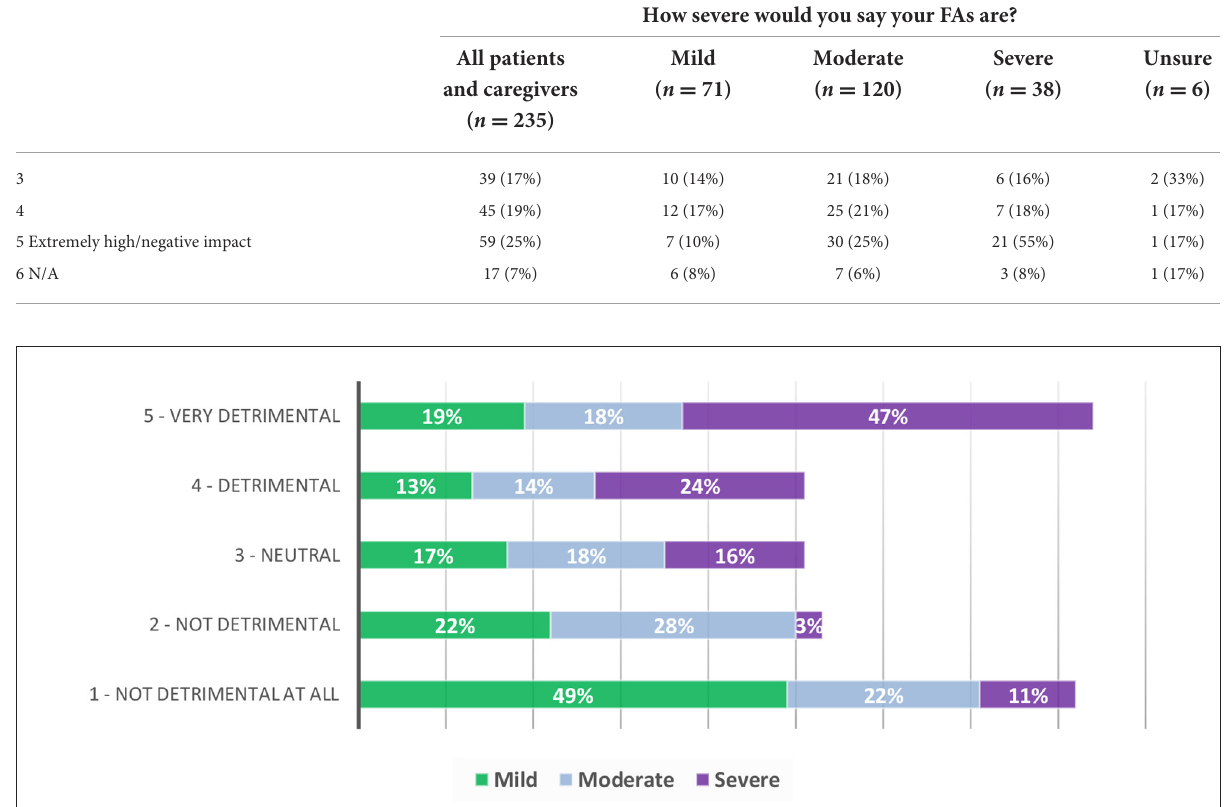
somewhat troublesome (4 or 5 on the scale), associated with increased severity. Of the 16% of data subjects who reported severe FAs, 84% (CI: 68.5, 93.8) reported them as being very to extremely